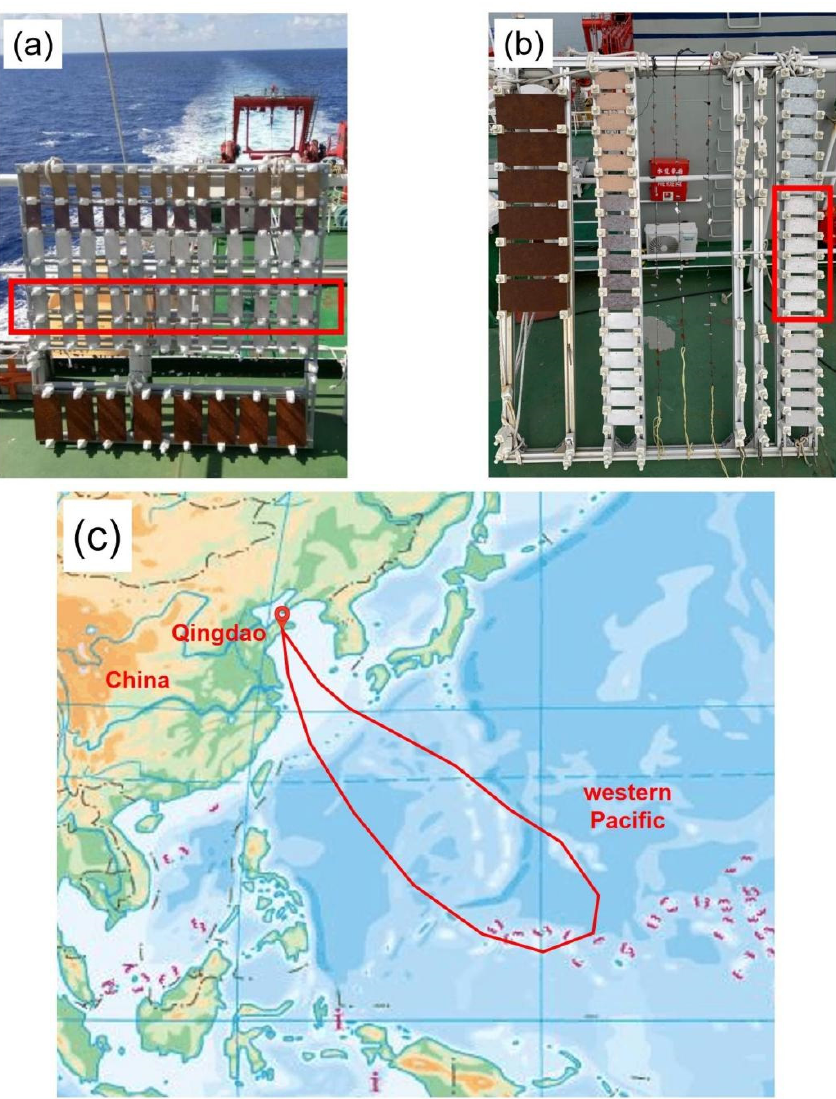
Figure 1. The dynamic natural environment exposure test environment. ( a ) Test rack A, ( b ) test rack B, ( c ) navigation range.